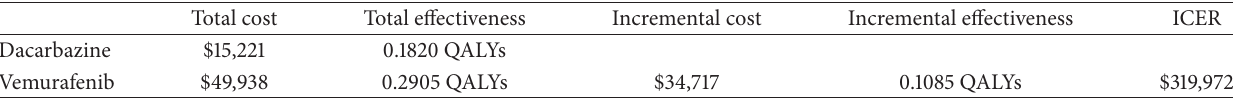
Table 3: Base case cost-effectiveness of vemurafenib relative to dacarbazine. Total cost Total effectiveness Incremental cost Incremental effectiveness ICER Dacarbazine $15,221